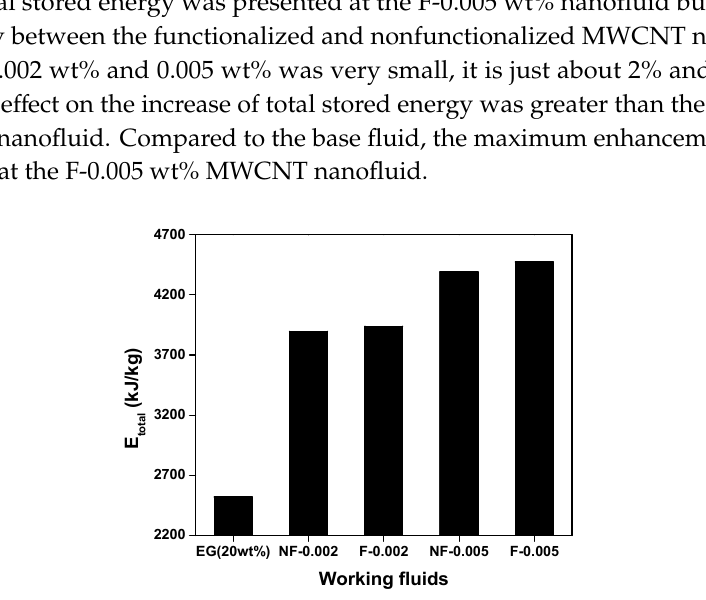
Figure 15. Comparison of photo-thermal energy conversion efficiency for different MWCNT nanofluid with time.